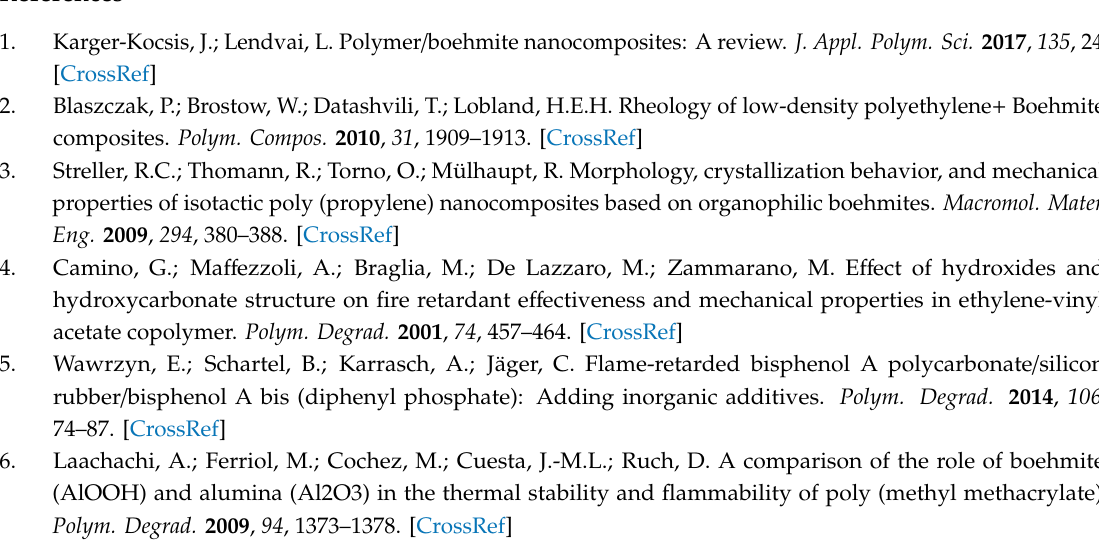
Figure A8. Room temperature ATR-IR spectra of BNPs, anhydride hardener and the masterbatch mixture of BNPs and MTHPA.